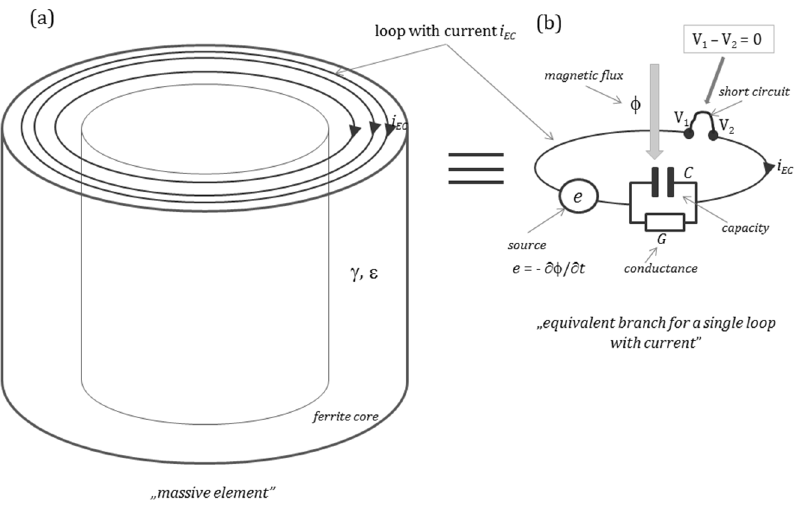
Figure 3. Massive element with loop currents ( a ) and the equivalent branch for a single loop with a current ( b ) .